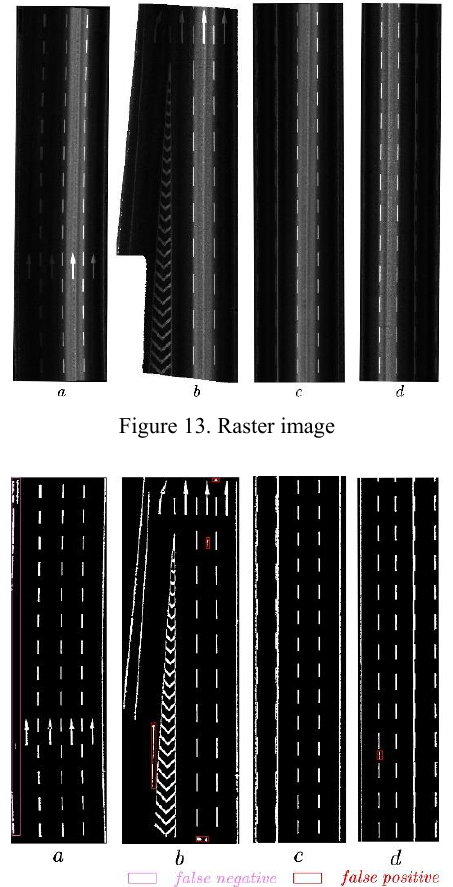
Figure 14. Adaptive threshold segmentation